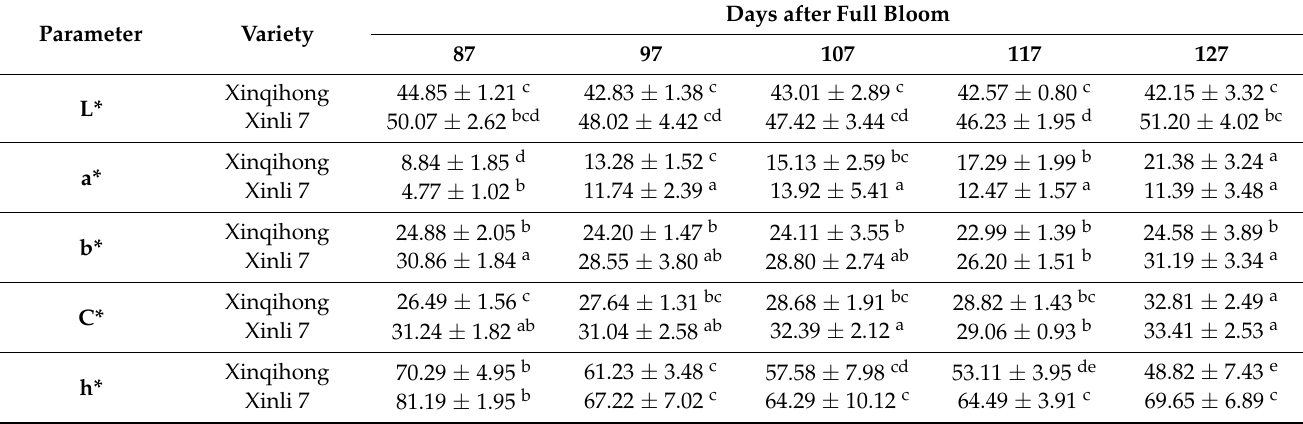
Table 2. Peel color parameters of ‘Xinqihong’ and ‘Xinli 7 (cid:48) red pear varieties during development.